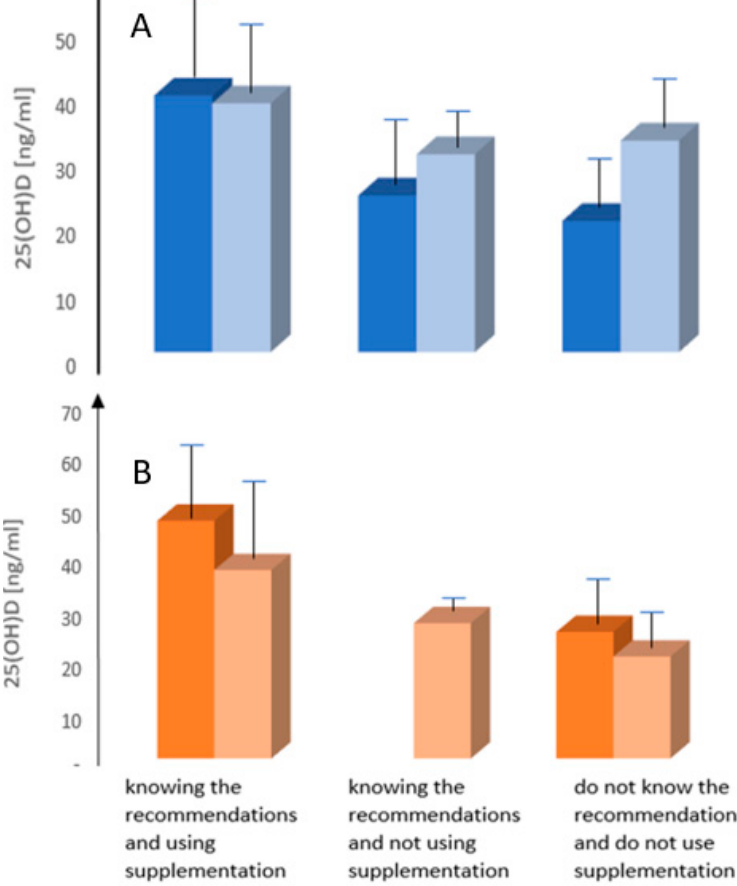
Figure 4. Mean serum 25(OH)D concentration ( ± SD—error bars) in the groups of women treated for breast cancer depending on the knowledge of vitamin D supplementation guidelines and sup- plementation of vitamin D. ( A )—Group A—women treated for breast cancer tested the first time in winter. ( B )—Group B—women treated for breast cancer tested the first time in summer. Dark ( left ) bars in the pair—values and data before inclusion into the study; pale bars ( right ) in the pair values and data during second testing half year later.